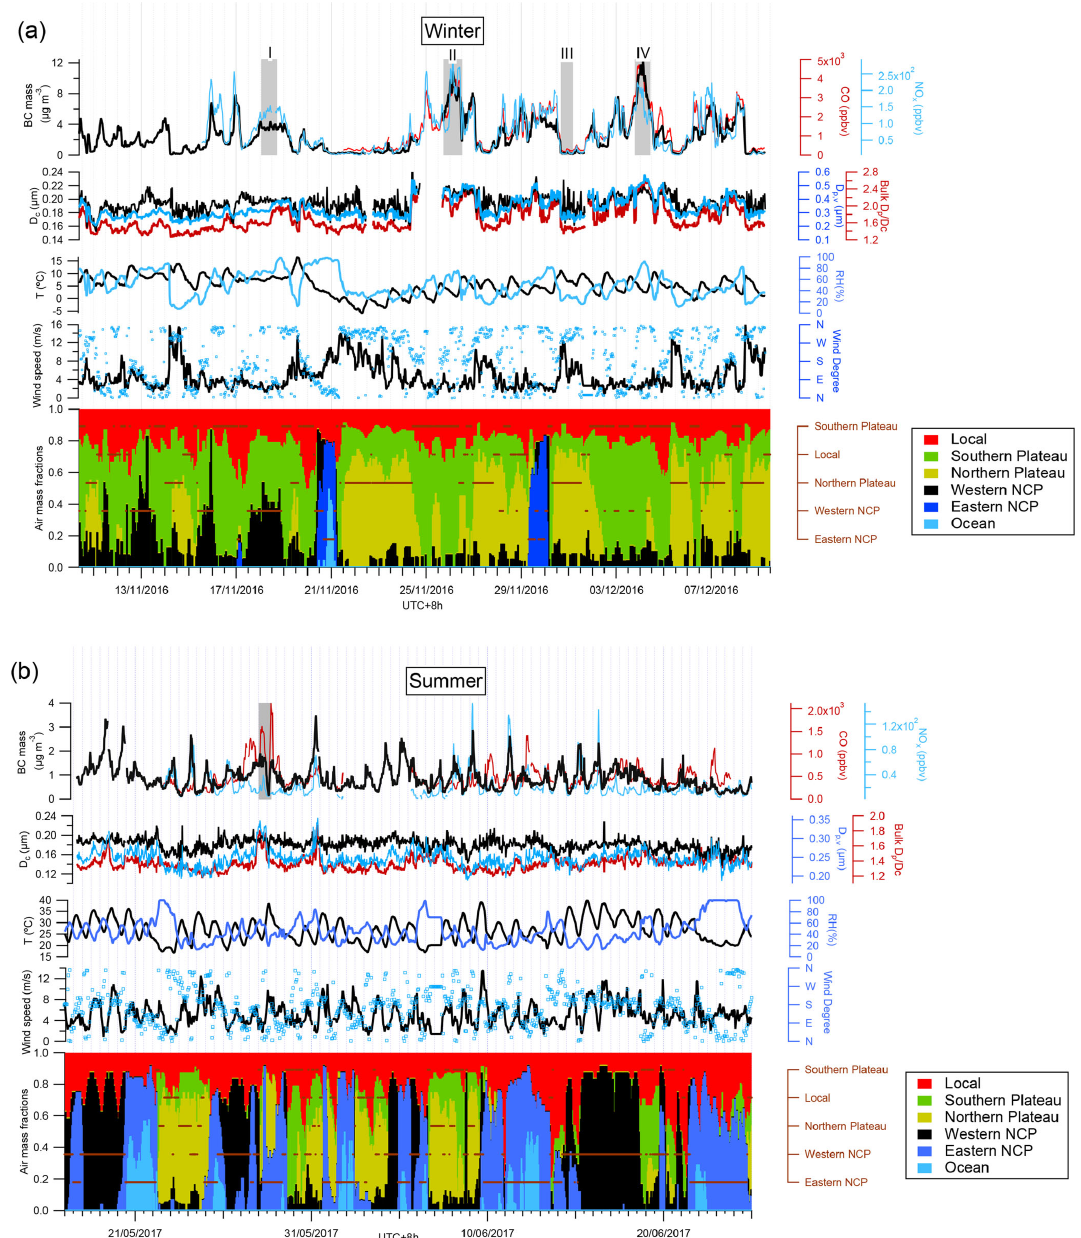
Figure 3. Time series of BC-related properties in the winter (a) and summer (b) experiments. From top to bottom subpanels: BC mass loading, CO and NO x ; BC bulk D p /D c , core mass median diameter (MMD) and coated volume-equivalent diameter; ambient temperature and RH at z = 8m; wind speed and direction at z = 120m; air mass fractions from different origins based on back-trajectory analysis, with the brown horizontal lines indicating the classified air mass types. The vertical grey shades mark the periods for the detailed mixing state analysis in Fig.